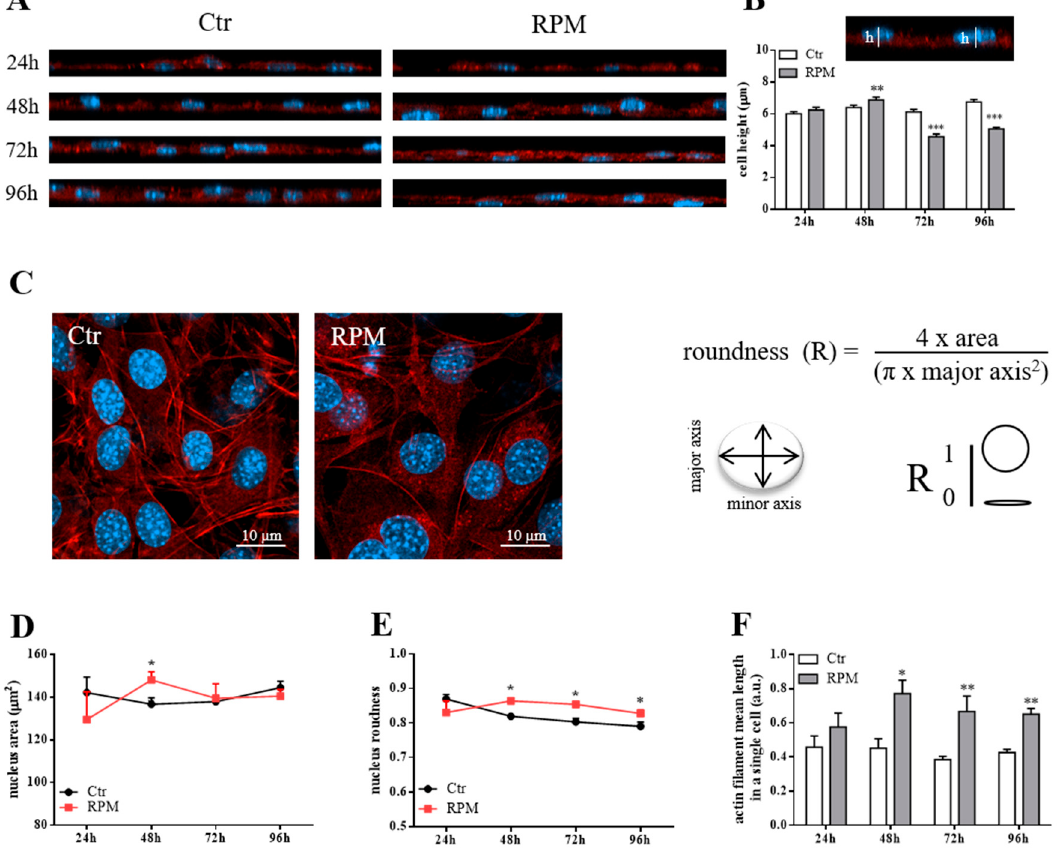
Figure 1. Morphological assessment of MC3T3-E1 cells exposed to s-microgravity conditions. ( A ) Representative orthogonal projections (XZ) obtained from the z-stack images from control cells at 1g (Ctr) or cells exposed to s-microgravity (RPM) at different times (24, 48, 72, and 96 h), stained with Alexa Fluor 546 Phalloidin (for f-actin) and DAPI (for nuclei). ( B ) The graph shows quantitative analyses of cell height. This was calculated as described in Materials and Methods and as shown in the example image (h = height). ( C ) Representative single optical section-images of Ctr or RPM cells, stained with Alexa Fluor 546 Phalloidin (for f-actin) and DAPI (for nuclei), and the formula used to assay nuclei roundness. ( D – F ) Quantitative analyses of nucleus area, nucleus roundness, and the mean length of actin filaments of Ctr or RPM cells at different exposure times (24–96 h). The data in the graphs are presented as the means ± SEM from three independent experiments. * p < 0.05 vs. Ctr; ** p < 0.01 vs. Ctr, *** p < 0.001 vs. Ctr.